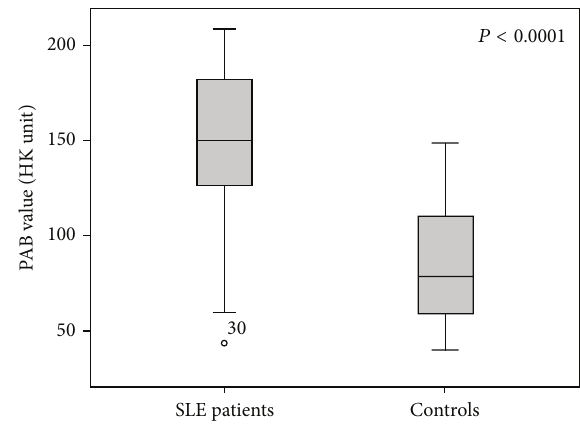
Figure 1: Comparison of PAB values between SLE patients and con- trol